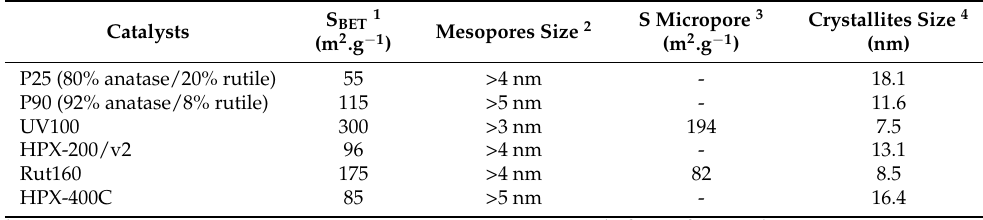
Figure 1. Diffractogram of commercial TiO 2 samples. Table 1. Textural features and particle sizes of commercial TiO 2